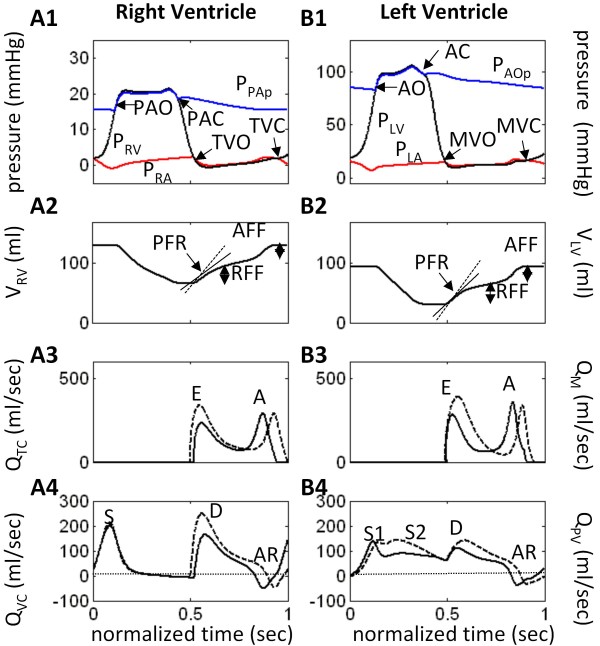
Model Waveforms for Impaired Relaxation Case. Model-generated pressure, volume and flow waveforms for the impaired relaxation (IR) case. Dashed line plots are the control case for comparison. Abbreviations are as in Figure 2. See text for details.